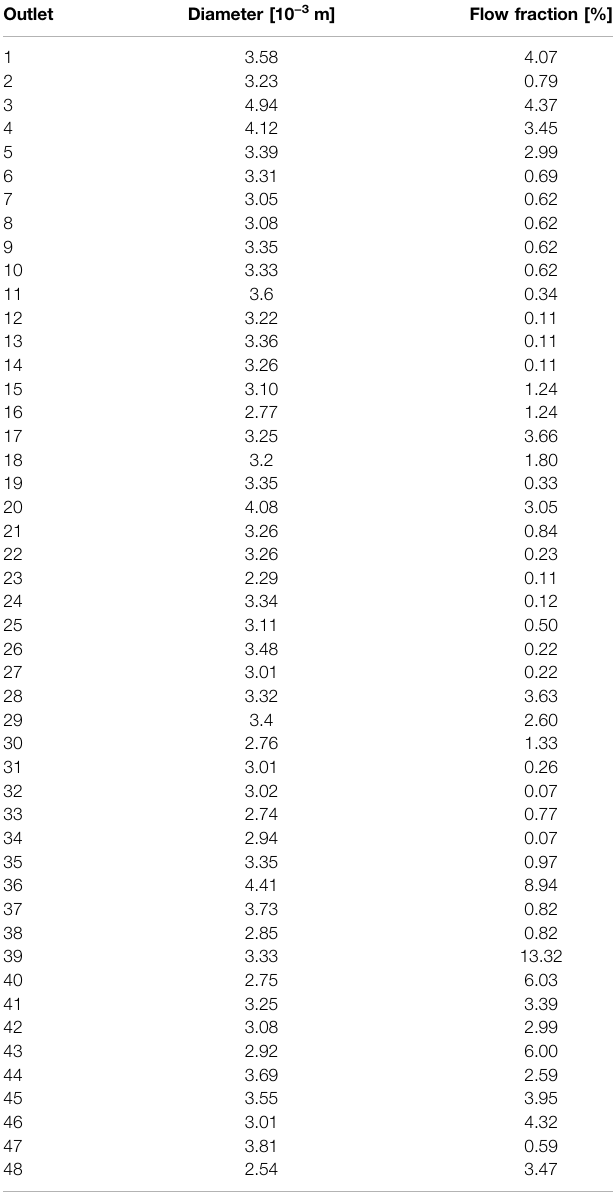
TABLE 2 | Overview of the sizes and fl ow fractions for the 48 outlets of Geometry 1. Outlet Diameter [10 − 3